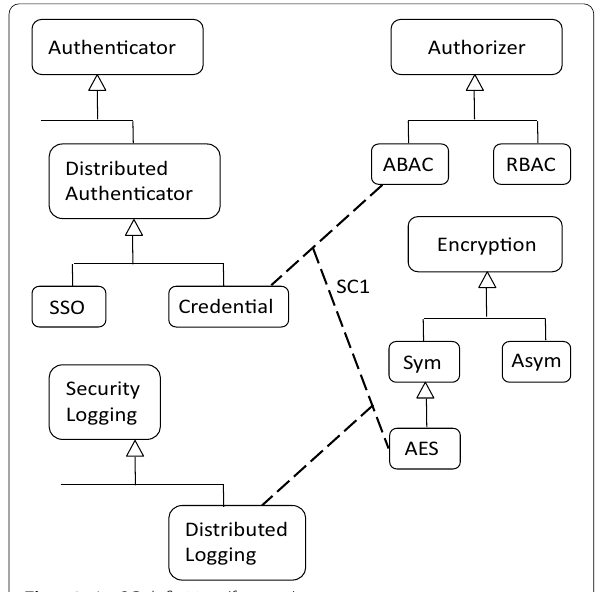
Fig. 10 An SC definition (from